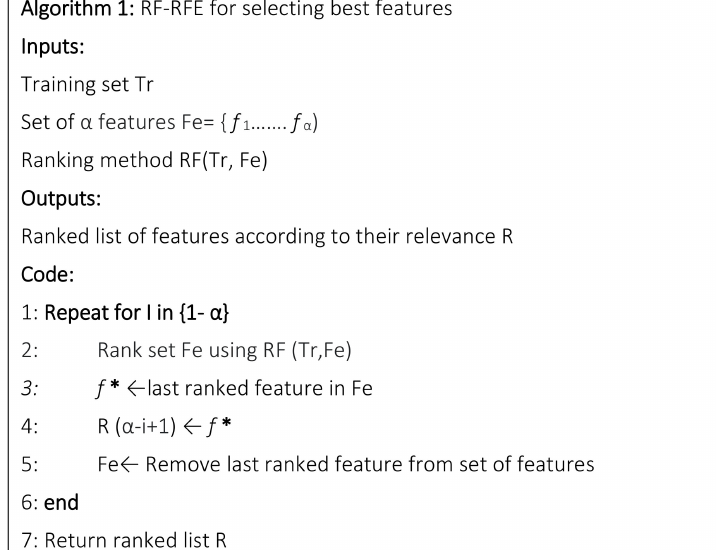
Figure 3. Pseudo-code of recursive feature elimination